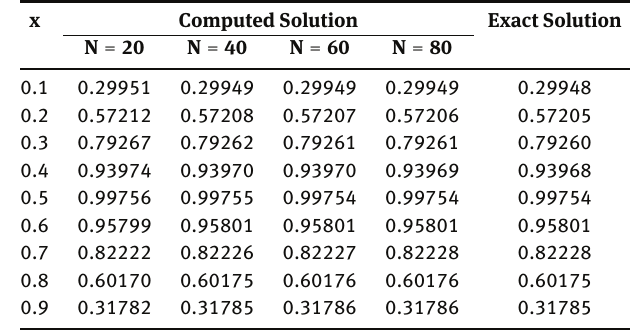
Table 2: Comparison of the Numerical solution with the exact solu- tion at different space points of example-1 at T = 0.01 for ν = 0.02 and Δt = 0.001